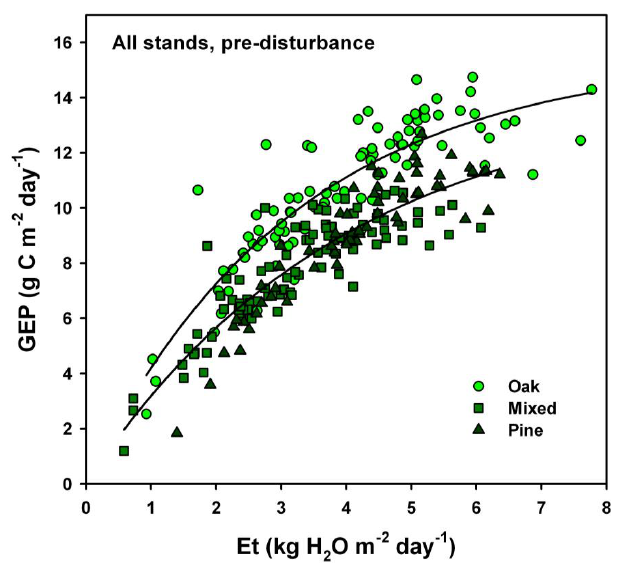
Figure 4. The relationship between daily evapotranspiration (Et, mmday − 1 ) and daily gross ecosystem production (GEP, gCm − 2 day − 1 ) for the oak, mixed and pine stands from 1 June to 31 August 2005, before disturbance. Statistics are in Table 4.